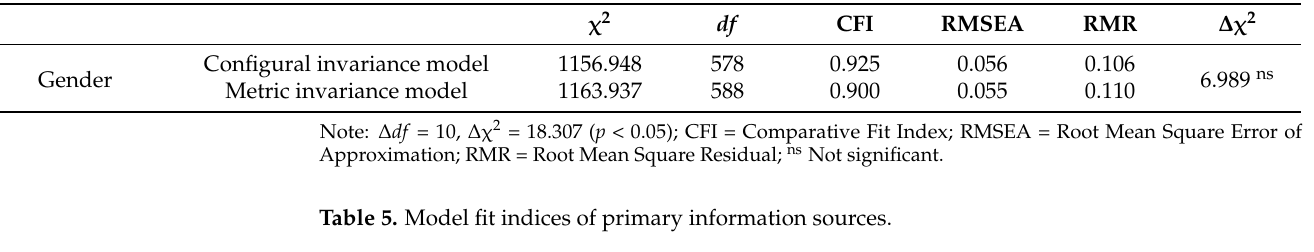
Table 4. Model fit indices of gender.